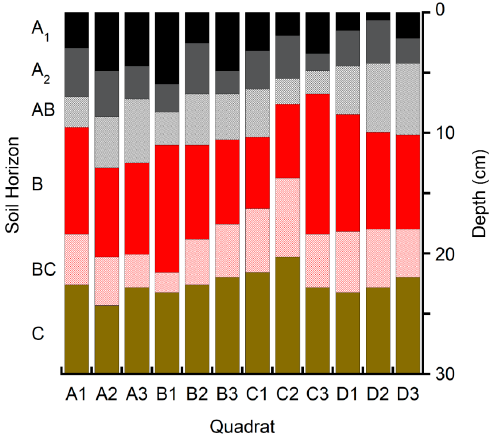
Figure 6. Soil profile in each quadrat from mineral surface to 30 cm depth of soil horizon. Colors of bars correspond to soil horizon appearing the left of the figure. The soil-extracted solution of the Pinus -dominated stand showed significantly higher pH within the four quadrats at the respective soil depths (Figure 7a). Na + concentration in the soil-extracted water in the mixed stand was significantly higher than that in the Pinus dominated stand at the surface layer (0–10 cm) of soil. NO 3 ‒ of soil-extracted water in the mixed stand and in the evergreen broadleaf stand was significantly higher than that of the pure Pinus stand in the 10–20 cm layers, and higher than that of the pure Pinus stand and the Pinus dominated stand at a 20–30 cm depth (Figure 7h). The SO 42 ‒ of soil-extracted water in the evergreen broadleaf stand was significantly higher than that in the Pinus dominated stand at a depth of 20–30 cm (Figure 7i). EC, K + , Mg 2+ , Ca 2+ , and Cl ‒ of the soil-extracted water showed no significant differences among the quadrats; however, K + and Ca 2+ concentrations in the evergreen broadleaf stand and in the Pinus dominated stand showed higher values at the surface layers of soil (Figure 7e,f).